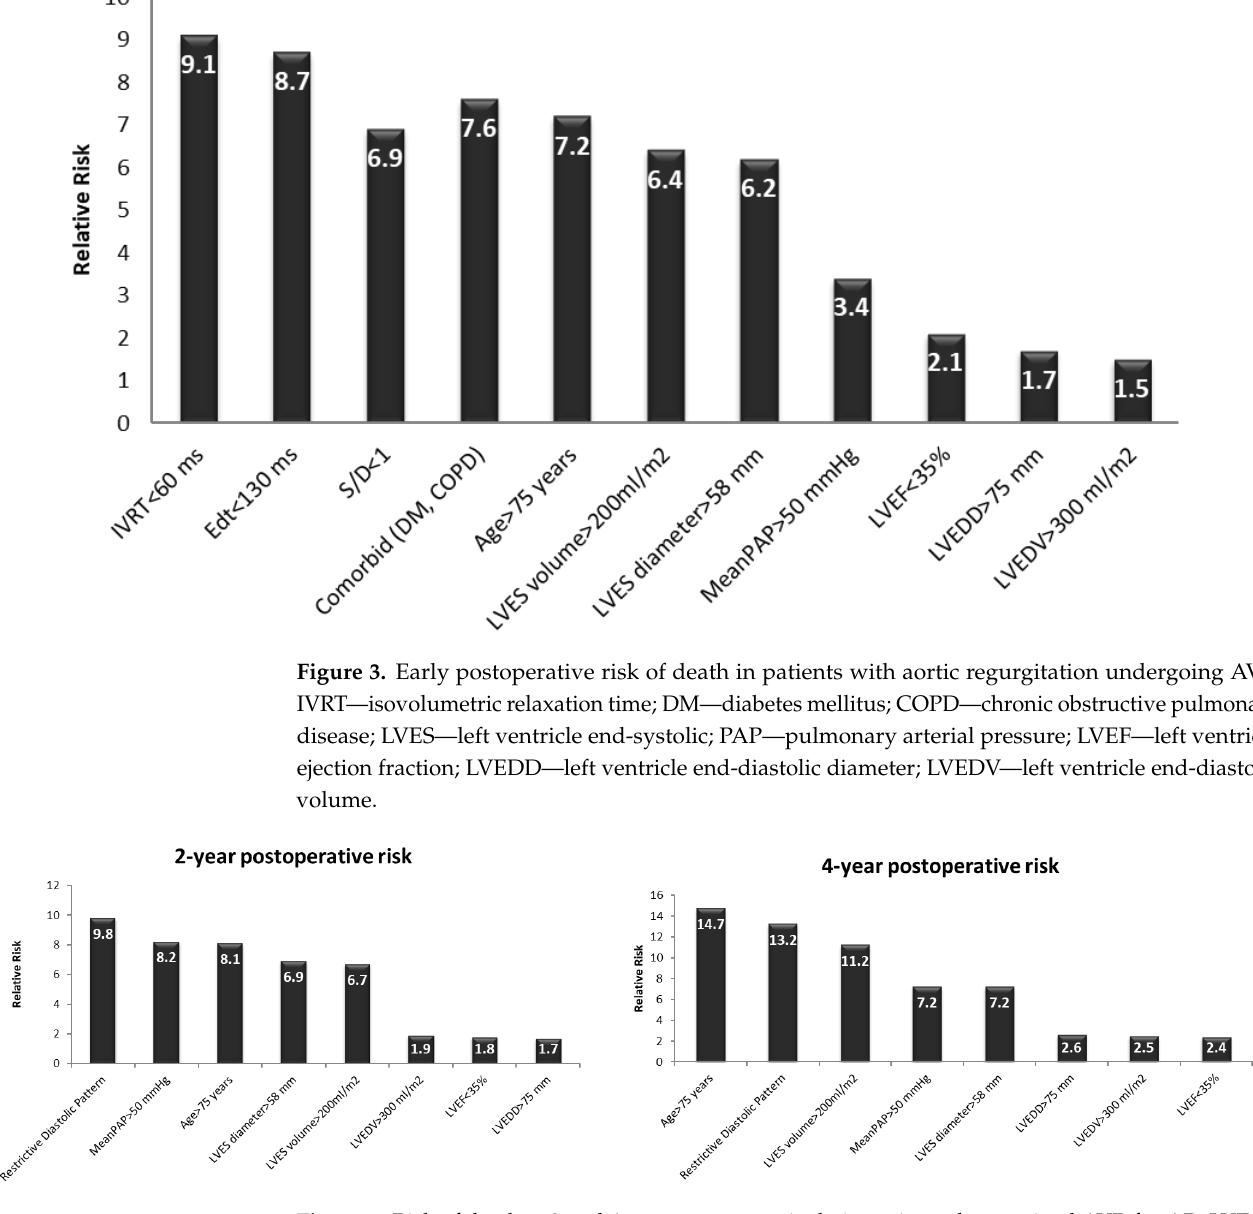
Figure 5. The percentage of patients with a favorable evolution depending on NYHA class and quality of life Score at 2 and 4 years postoperatively after AVR for AR. NYHA—New York Heart Association. 4. Discussion Severe AR leads to an increase in both preload (volume overload) and afterload, which in turn causes a combination of chamber dilation and hypertrophy, usually eccentric, that is generally associated with the worsening of diastolic function. The LVEF